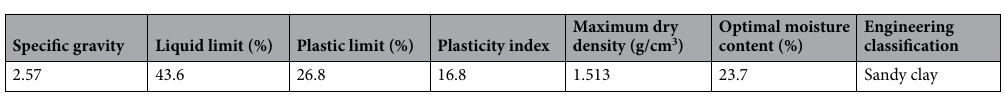
Figure 1. Test apparatus.